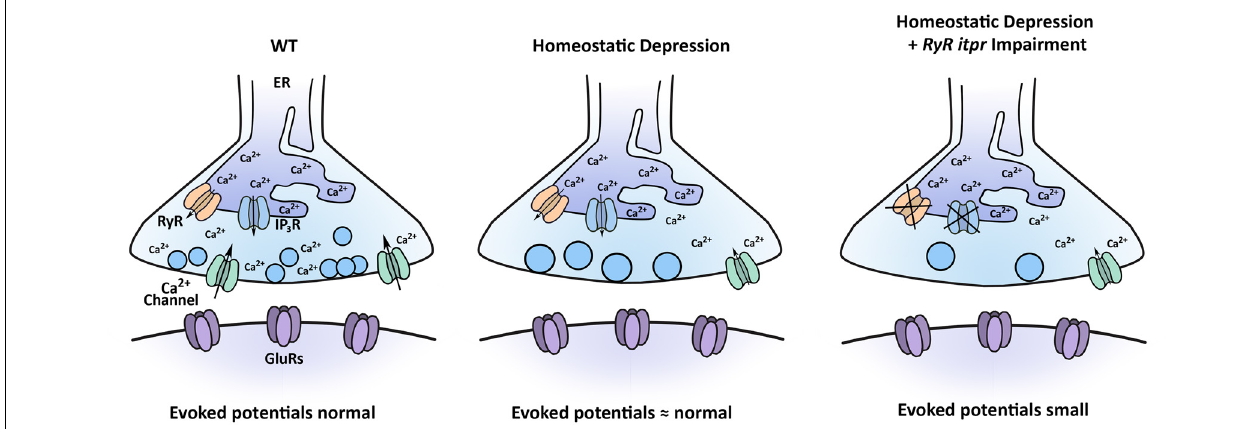
FIGURE 9 | Model for how multiple calcium sources interact with the process of PHD. Under baseline conditions, Ca V 2-type calcium channels contribute to synapse function, as may RyRs and IP 3 Rs. Under conditions inducing PHD, synaptic vesicles are enlarged, and QC is decreased, through regulation of sources of calcium. When PHD challenge is coupled with concomitant impairment of RyR and IP 3 R channels, evoked potentials are significantly diminished.